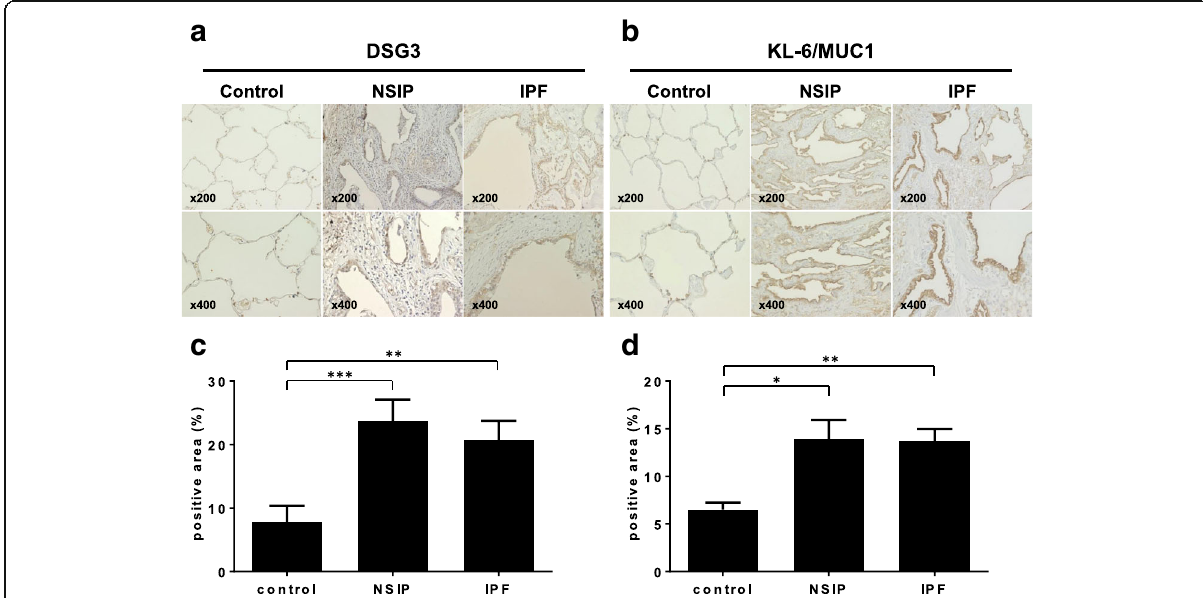
Fig. 2 The expression of ( a ) DSG3 and ( b ) KL-6/MUC1 are strong in the lung affected by IPF or NSIP as compared to the controls. Morphometric analysis for ( c ) DSG3 and ( d ) KL-6/MUC1 confirmed that the rate of positively stained area is significantly high in the lung affected by IPF or NSIP as compared to the controls. * P < 0.05; ** P < 0.01; *** P <